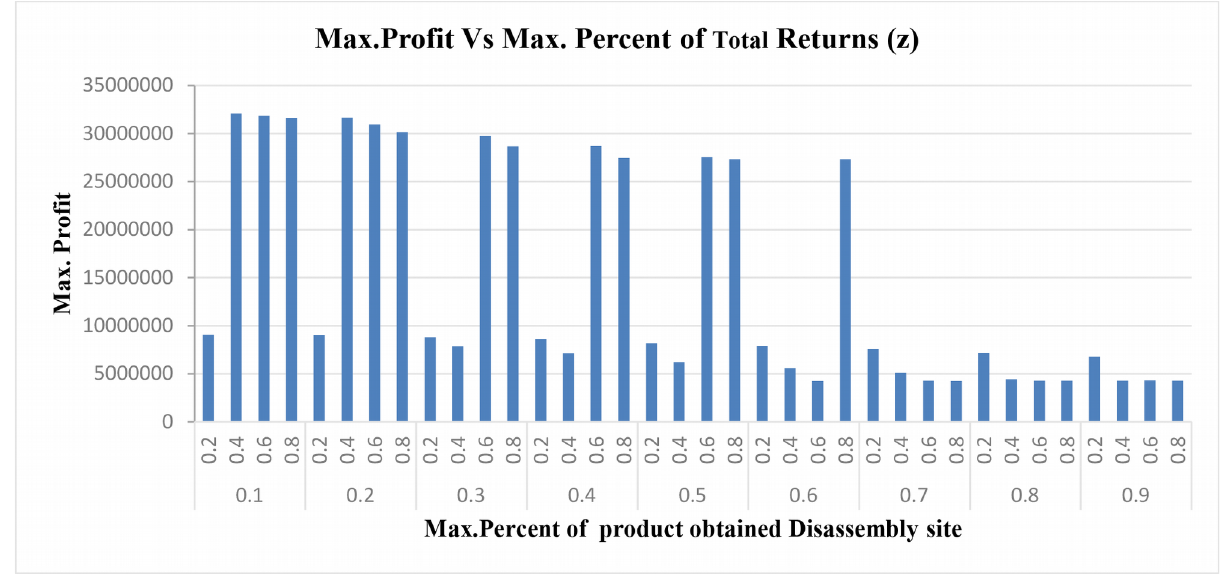
Figure 4. Profit Vs Percent of Total Returns of the product